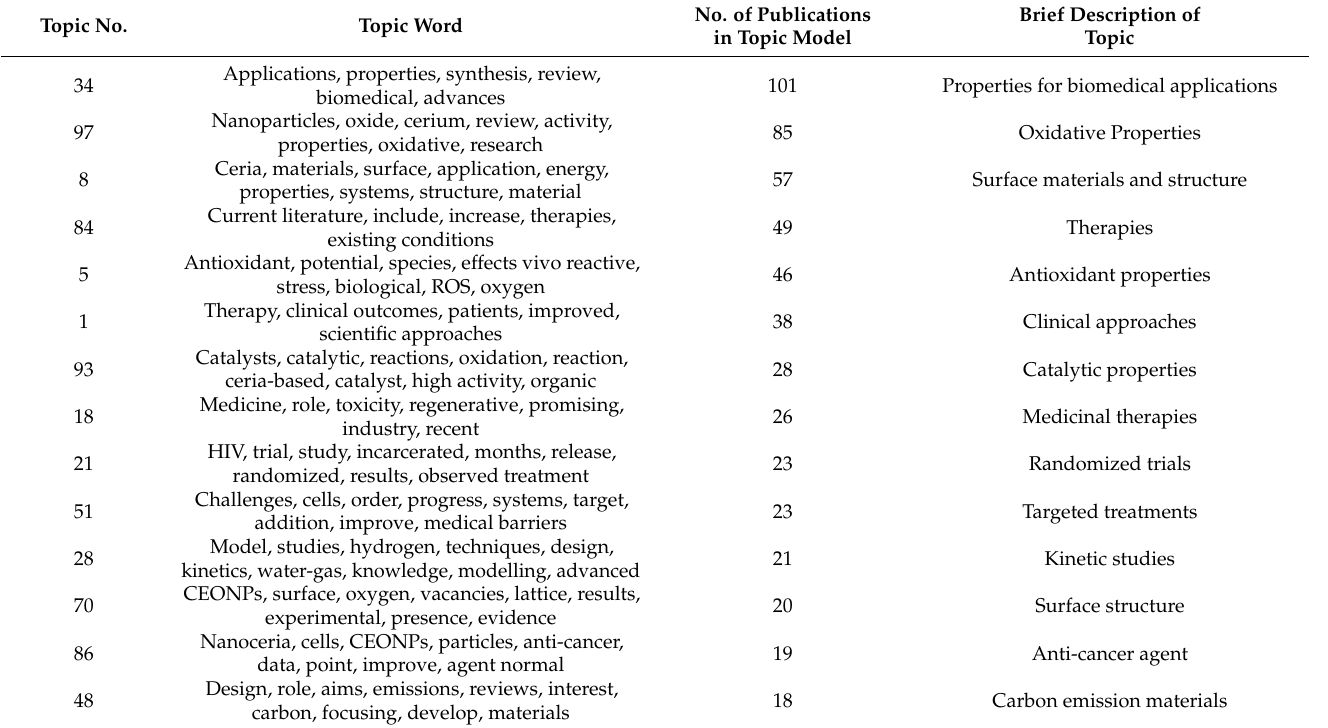
Figure 1. The top 19 topic models formulated from the dataset collected from PubMed (129 publications) with the SWIFT ‐ Review software, using the search term “cerium oxide OR ceria OR nanoceria OR nano ceria”. This search was refined to review, clinical trials, meta ‐ analysis, and research articles. Accessed on the 17 September 2020. Table 2. Top 19 topic models generated from PubMed dataset (129 publications) by SWIFT ‐ Review software using the search terms “cerium oxide OR ceria OR nanoceria OR nano ceria”. This search was refined to review, clinical trials, meta ‐ analysis, and research articles. The topics have been ordered by number of publications contributing to the topic model in descending order, with topic words and themes established.